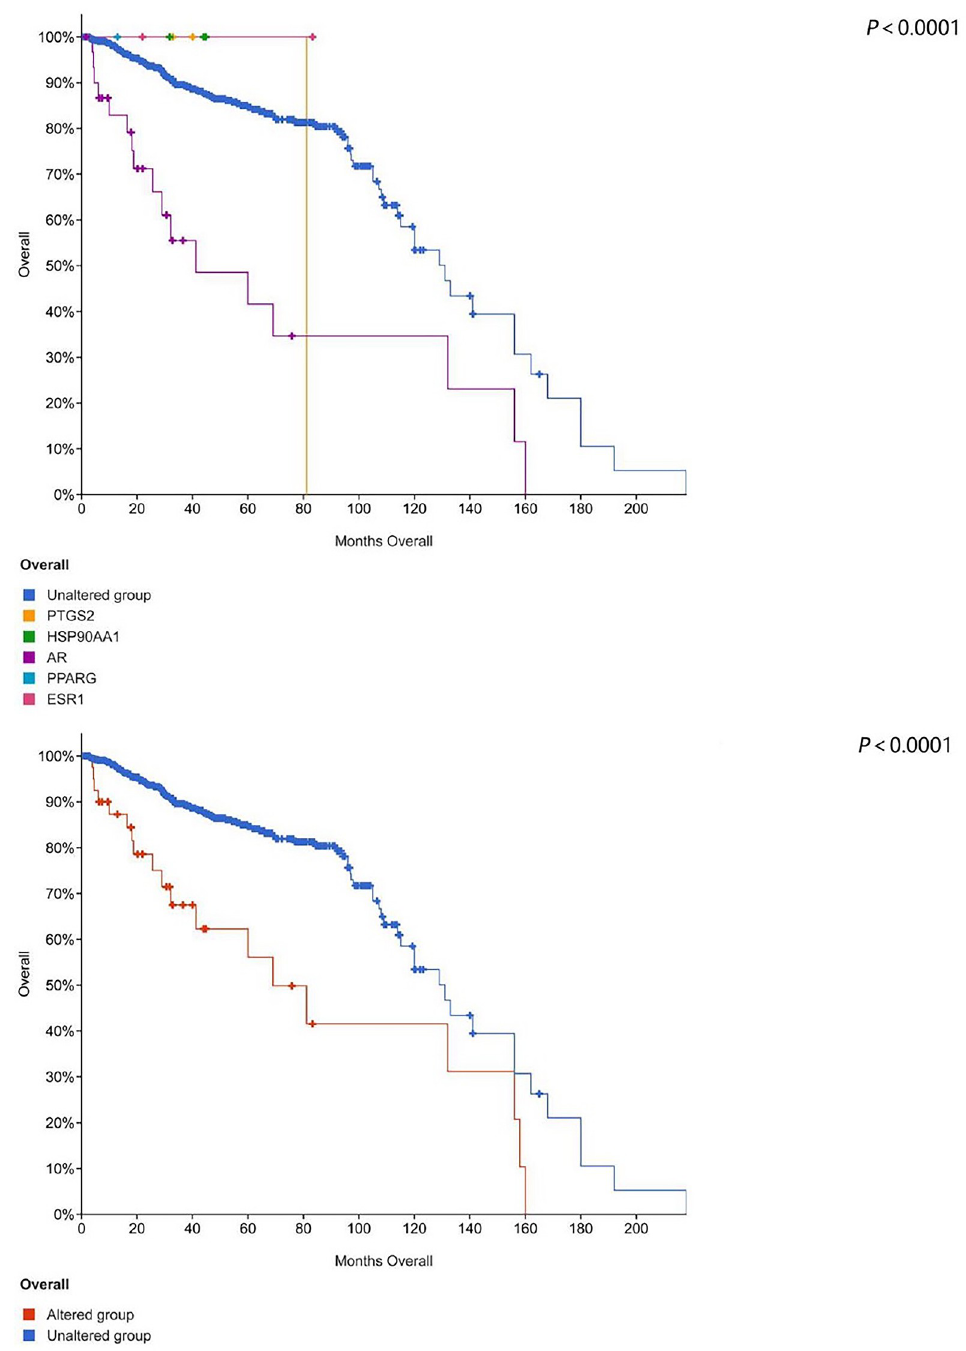
Fig 8. Survival analysis of five core proteins. Survival analysis involves five core proteins. The blue line in the figure indicates the survival of prostate cancer patients whose targets had not changed. Non-blue lines show changes in the survival of prostate cancer patients with changed